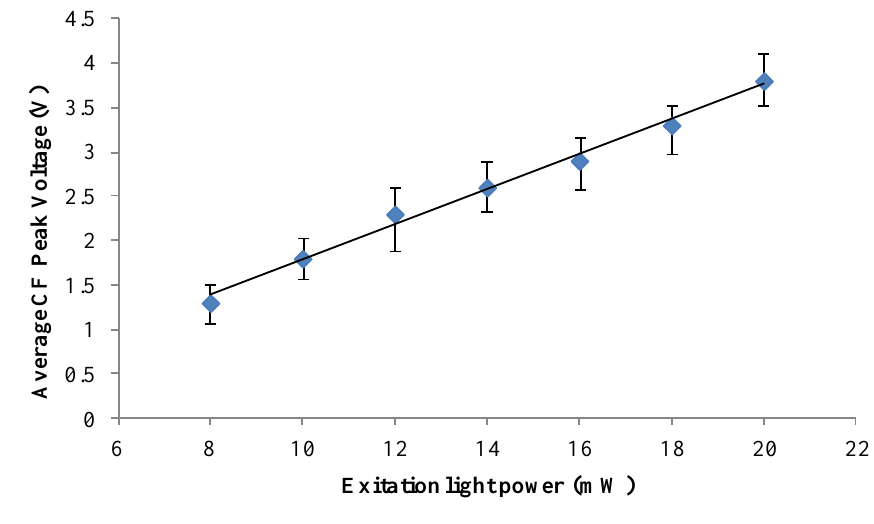
Figure 4. The relation between average chlorophyll fluorescence intensity of the microalgae cells ( Chlorella vulgaris) and the power of the excitation light. Data are the averages [mean ± Standard Error (S.E.)] of twenty-one repeated